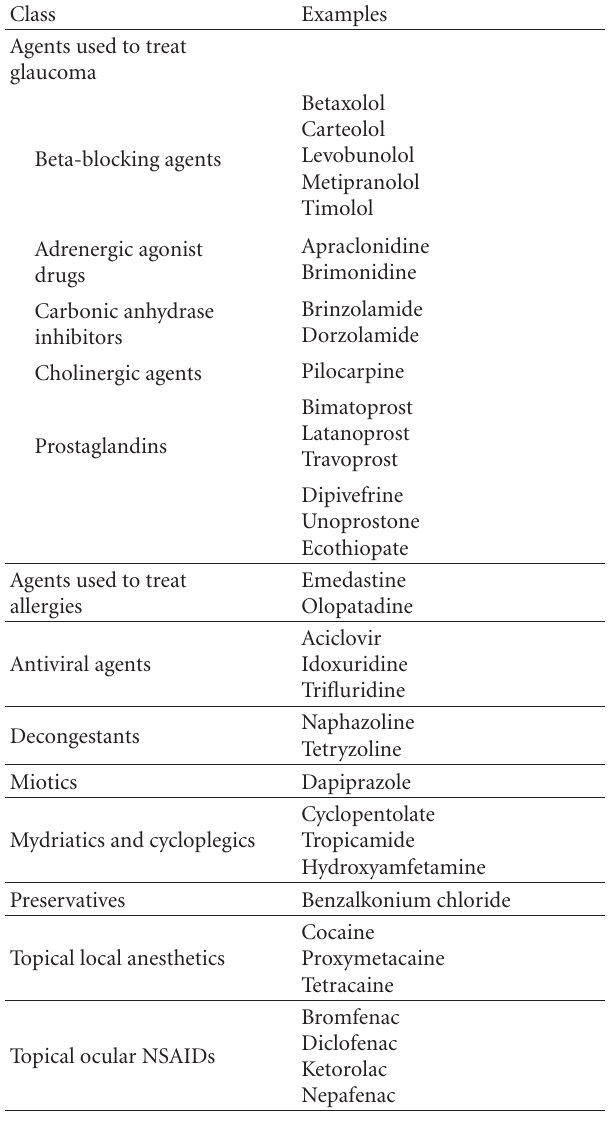
Table 4: Topical ocular drugs that may cause or aggravate dry eye